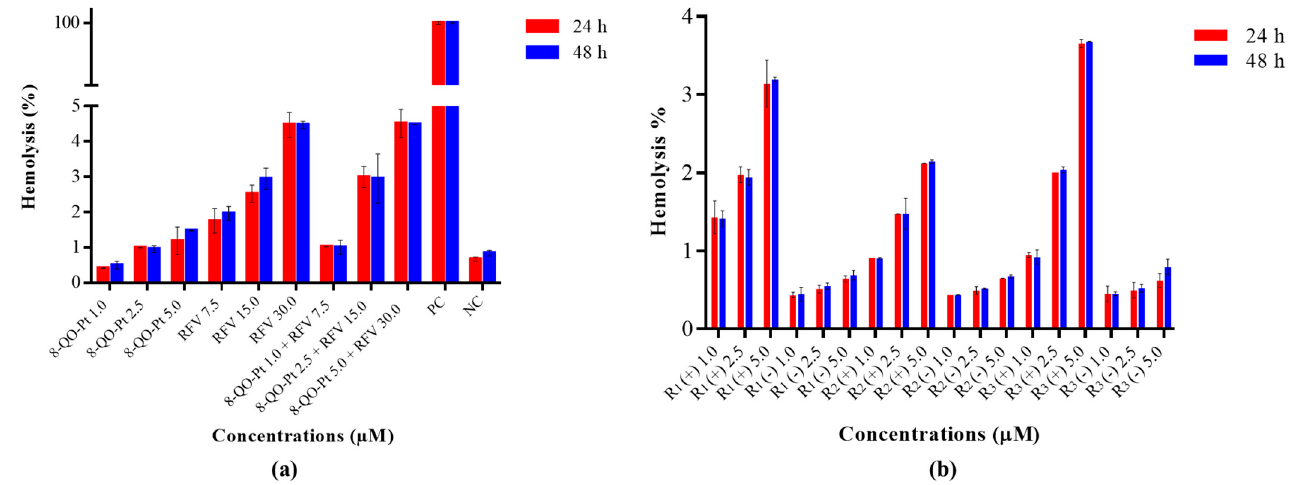
Figure 6. ( a ) Hemolysis degree of 8-QO-Pt, RFV, and their combinations after exposure to human blood cells for 24 h and 48 h. Controls: positive (PC) with 1.0% Triton X-100 and negative (NC) with untreated blood. ( b ) Hemolysis degree of 8-QO-Pt-loaded (+) and empty ( − ) formulations of NLC/RFV after exposure to human blood cells for 24 h and 48 h. Data are shown as mean ± SD.